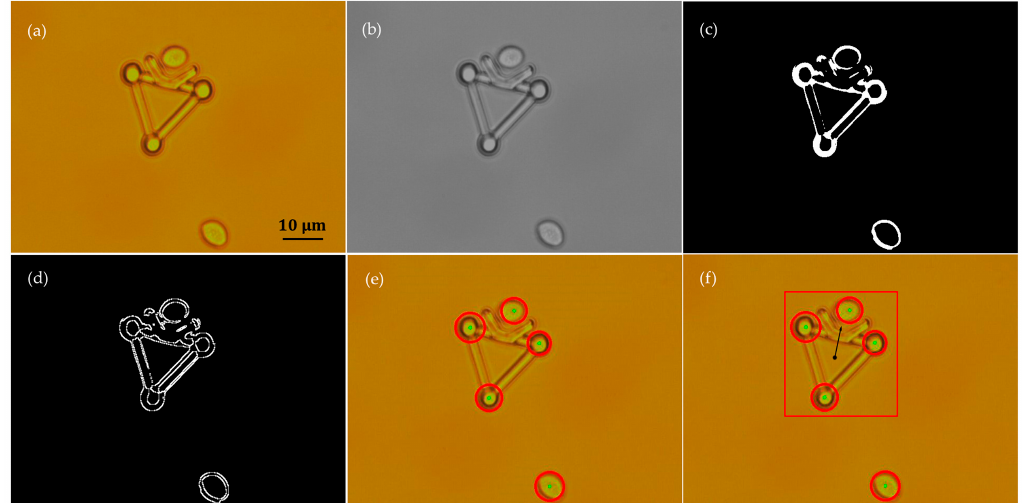
Figure 6. Recognition of the microtool poses from a mixture of two cells and the microtool through image processing. ( a ) Original color image. ( b ) Filtered grayscale image. ( c ) Binary image. ( d ) Edges of the microtool the cells. ( e ) Location of three handling spheres of microtool and two cells. ( f ) Poses of microtool.